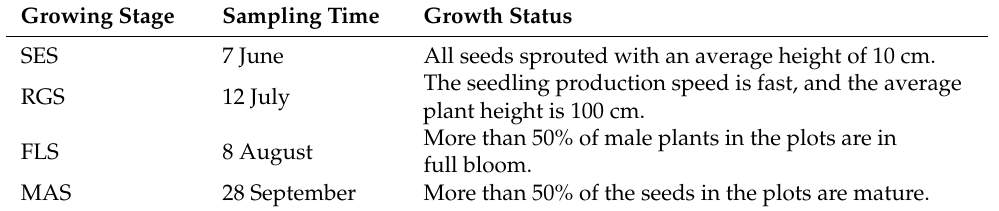
Table 1. Sampling period selection for physical, chemical, enzymatic, and microbiologic analysis. Growing